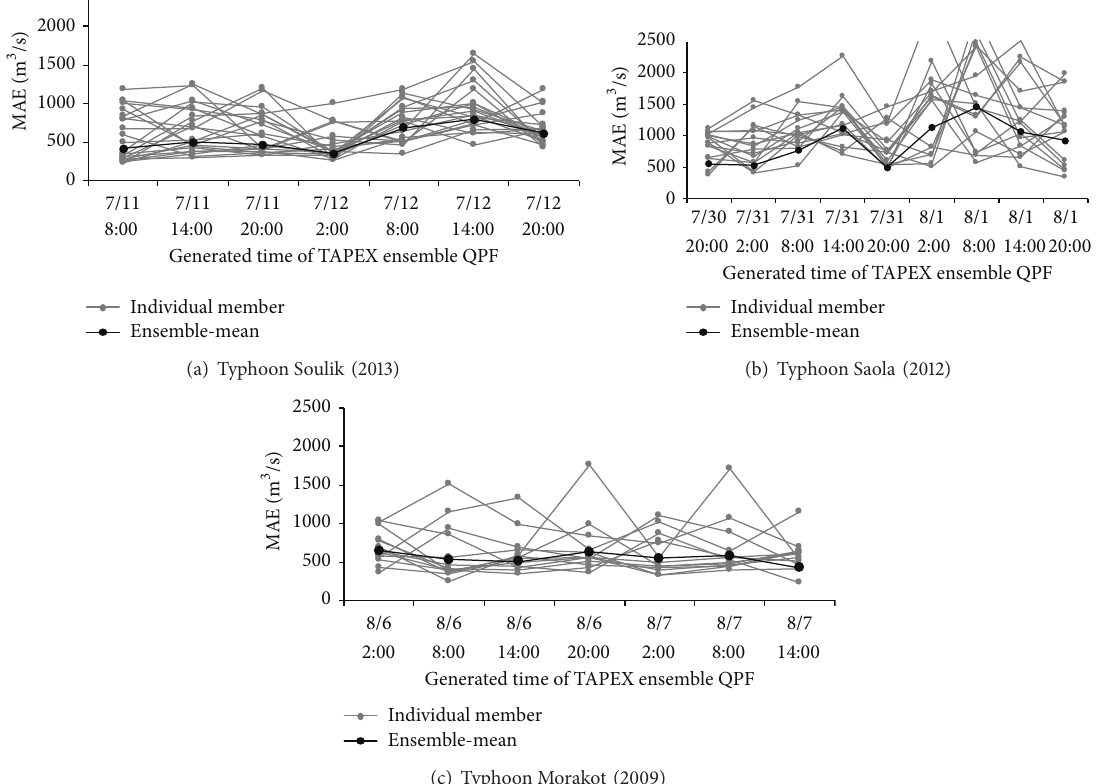
Figure 6: The evaluation of MAE. The average MAEs of the ensemble-mean was 530, 985, and 503 m 3 /s for Typhoon Soulik, Typhoon Saola, and Typhoon Morakot, respectively. The performance of the ensemble-mean is probably not the best, but we cannot know which individual member is the best before it actually